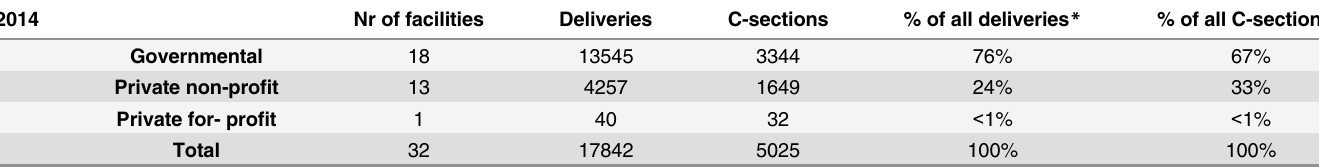
Table 2. 2014 Performance per type of health care sector